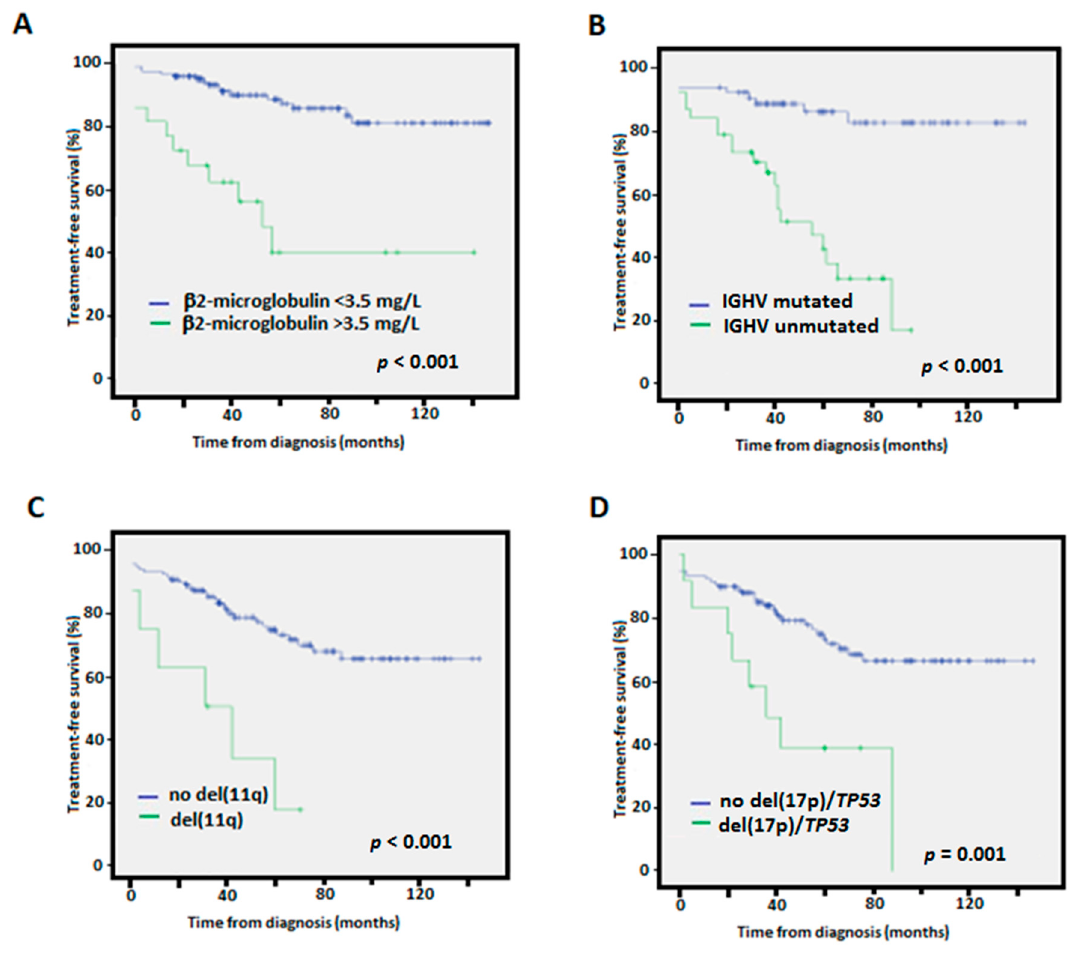
Figure 3. Kaplan-Meier treatment-free survival curves according to ( A ) β 2 -microglobulin levels, ( B ) IGHV mutational status, ( C ) presence of 11q deletions, ( D ) presence of 17p deletions/ TP53 mutation.